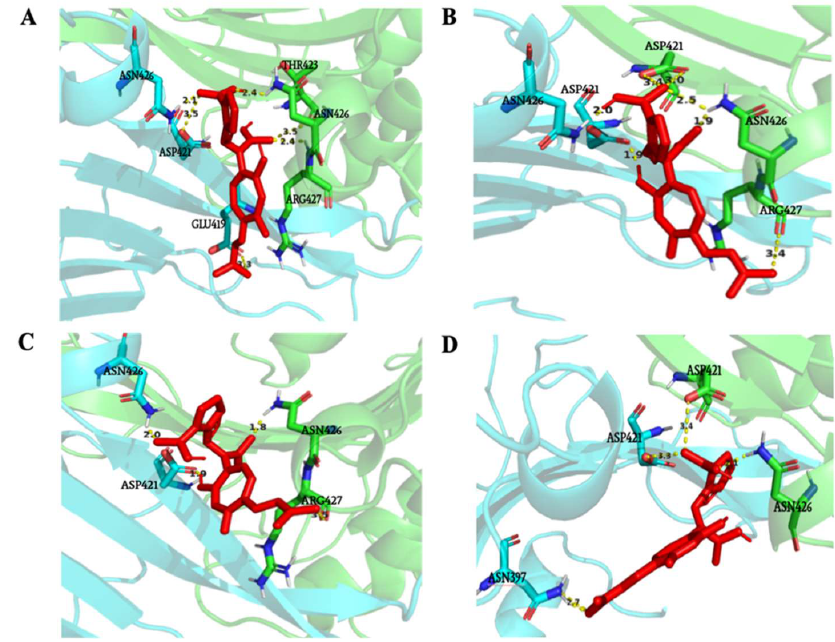
Figure 5. Analysis of the four possible interactions between ligand (in red) and the interface domains of the two protein monomers (blue and green): ( A – D ) represents the four putative positions between XPc and G6PD at the dimeric interface. Table 2. Results of the G6PD-ligand molecular docking scores Kcal·mole −1 at the interface domains of dimers and amino residues involved.